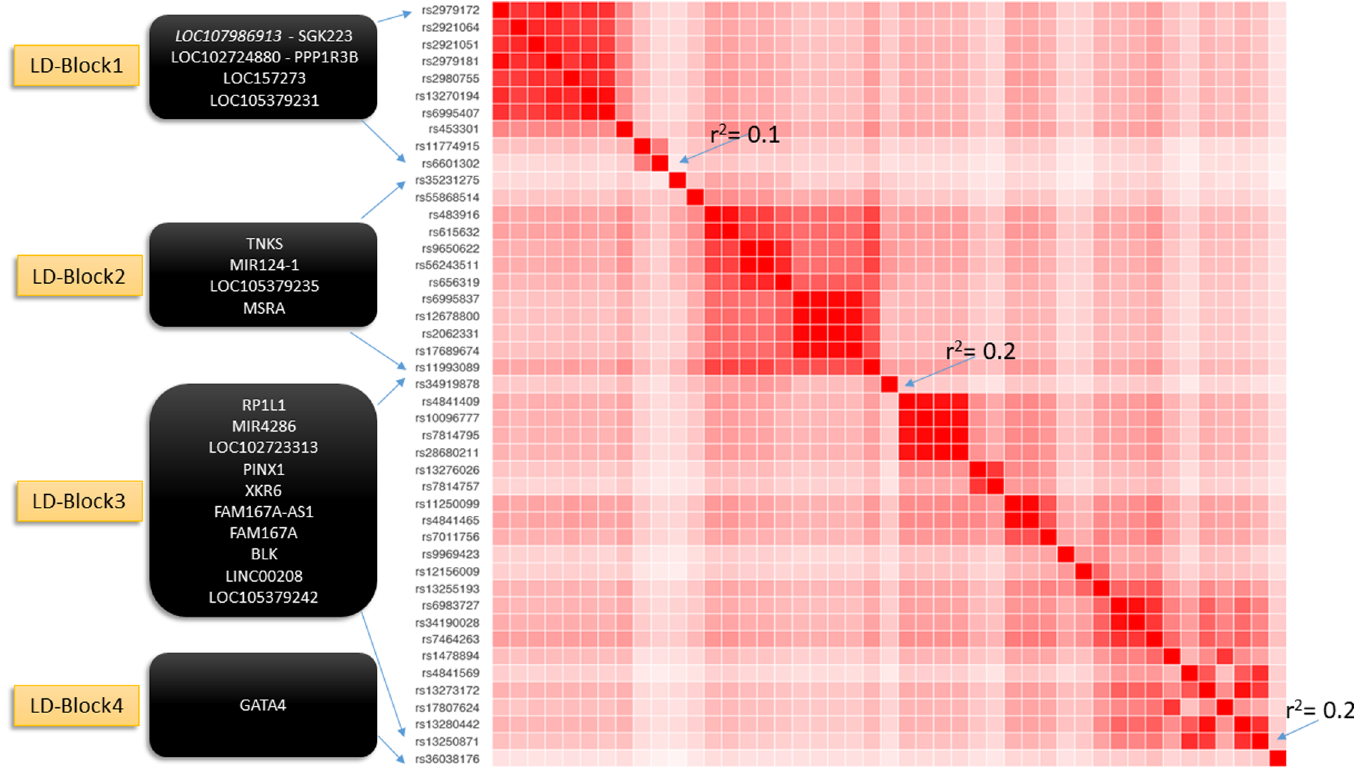
Fig 1. Identification of four independent LD blocks in the 8p23.1 region (~3 . 3MBs ).